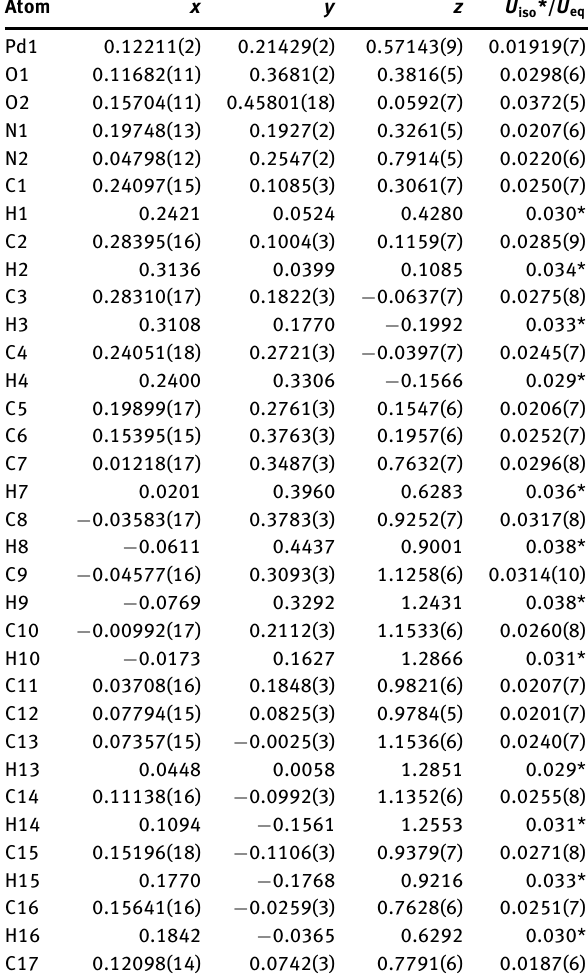
Table 2: Fractional atomic coordinates and isotropic or equivalent isotropic displacement parameters (Å 2